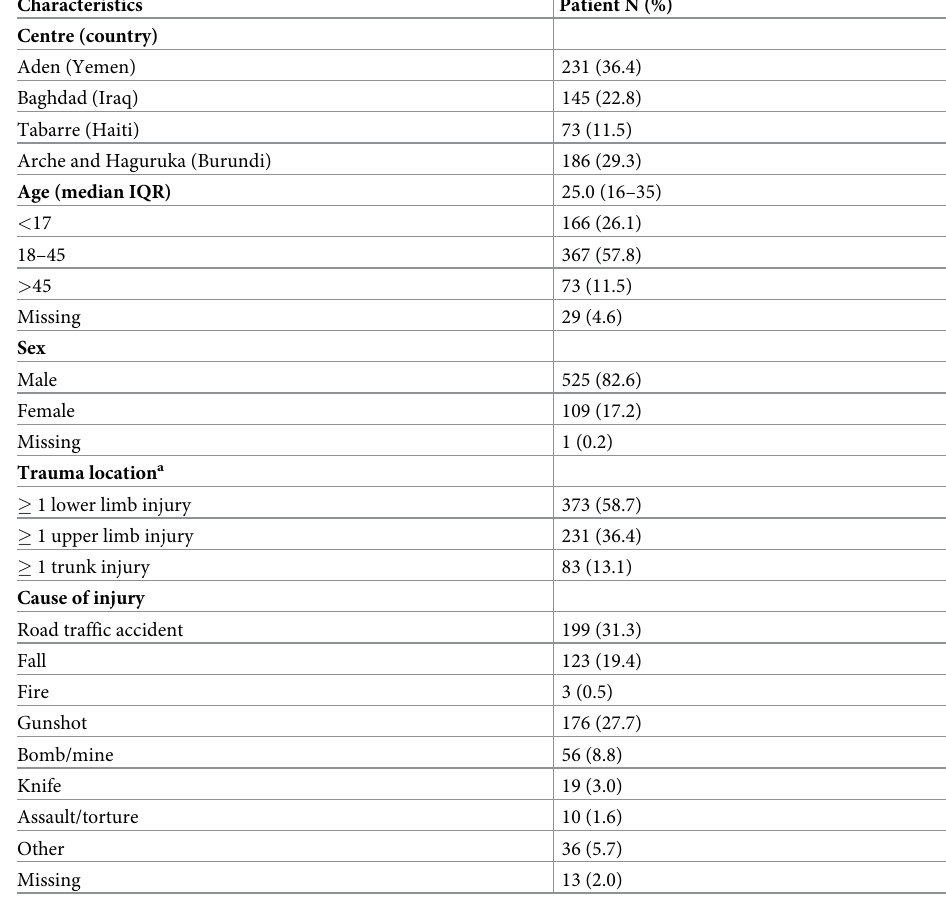
Table 1. Characteristics of the 635 patients included in the item reduction analysis.